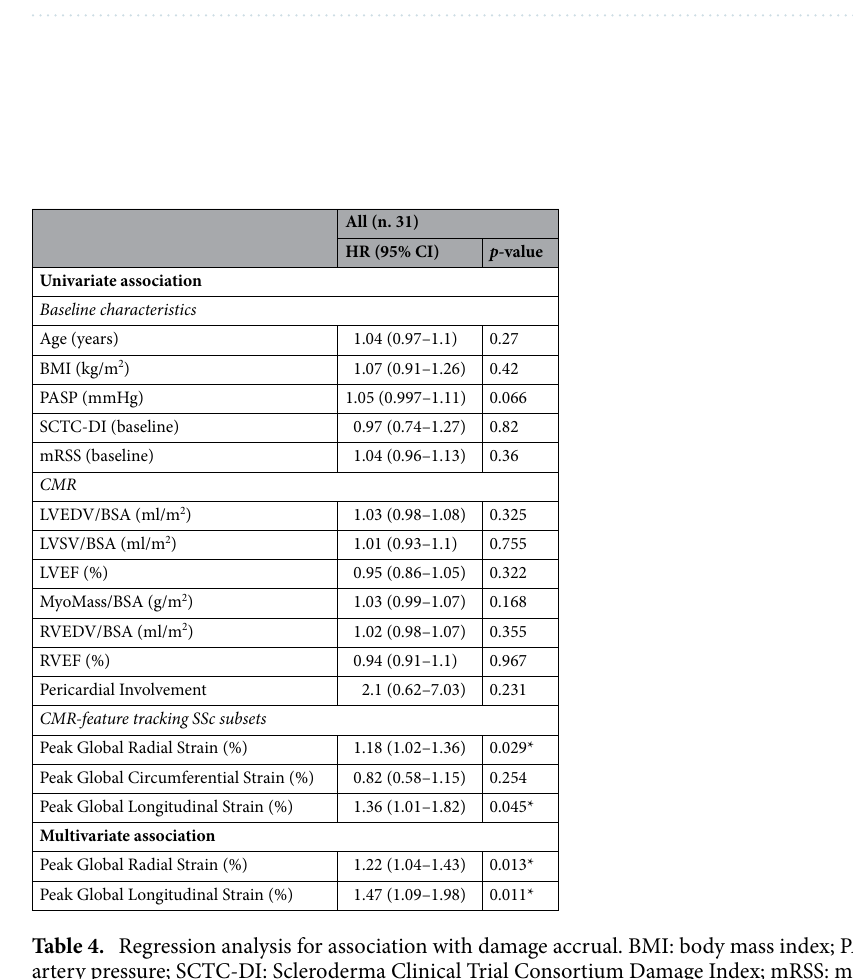
Table 3. Pearson’s correlation. r: coefficient of Pearson; BMI: body mass index; PAP: pulmonary artery pressure; SCTC-DI: Scleroderma Clinical Trial Consortium Damage Index; mRSS: modified Rodnan Skin Score; LVEDV: left ventricular end-diastolic volume; BSA: body surface area; LVSV: left ventricular systolic volume; LVEF: left ventricular ejection fraction; MyoMass: myocardial mass; RVEDV: right ventricular end-diastolic volume; RVEF: right ventricular ejection fraction; GLS: global longitudinal strain; GCS: global circumferential strain; GRS: global radial strain. *Significant test; p -value less than 0.05. **Significant test; p -value less than 0.01.